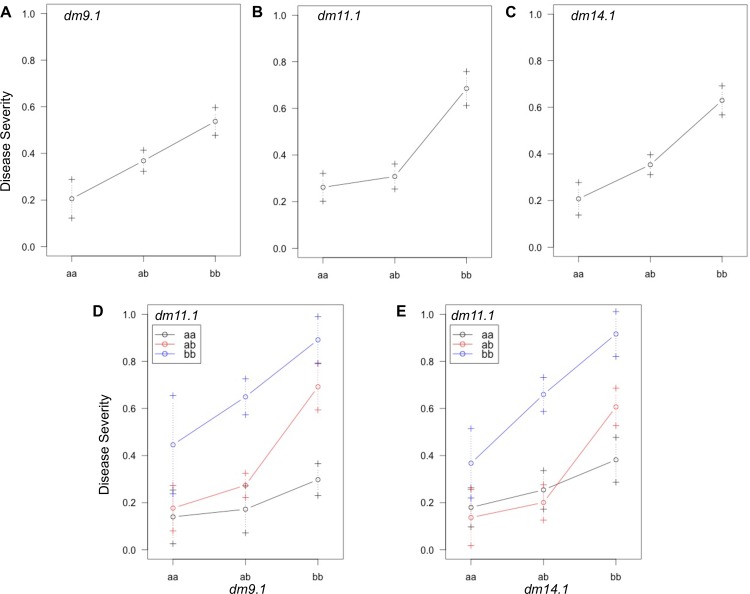
Effect and interaction plots for three QTL detected in environment NJSN14.MRI x SB22 F2 genotype means (circles) ± 1 SE (error bars) for (A) minor QTL dm9.1, (B) major QTL dm11.1 and (C) minor dm14.1. Two-QTL genotype by genotype means ± 1 SE for (D) dm11.1 by dm9.1 and (E) dm11.1 by dm14.1. Allele ‘a’ is inherited from downy mildew resistant grandparent MRI and allele ‘b’ is inherited from susceptible grandparent SB22. Error bars represent ±1 SE.